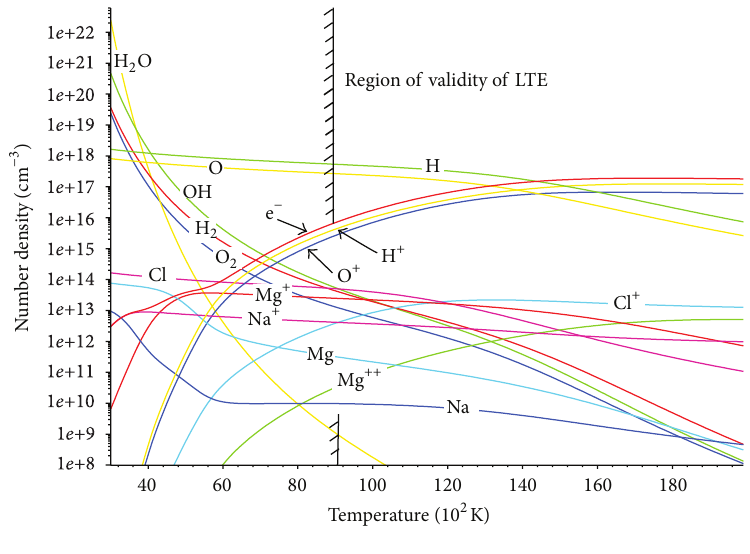
F 1: Species densities as function of temperature, for plasma of MgCl under thermal equilibrium